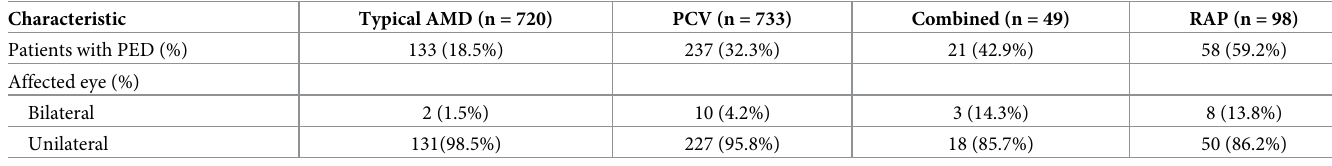
Table 4. Clinical characteristics of patients with PED in each AMD subtype. Characteristic Patients with PED (%) Affected eye